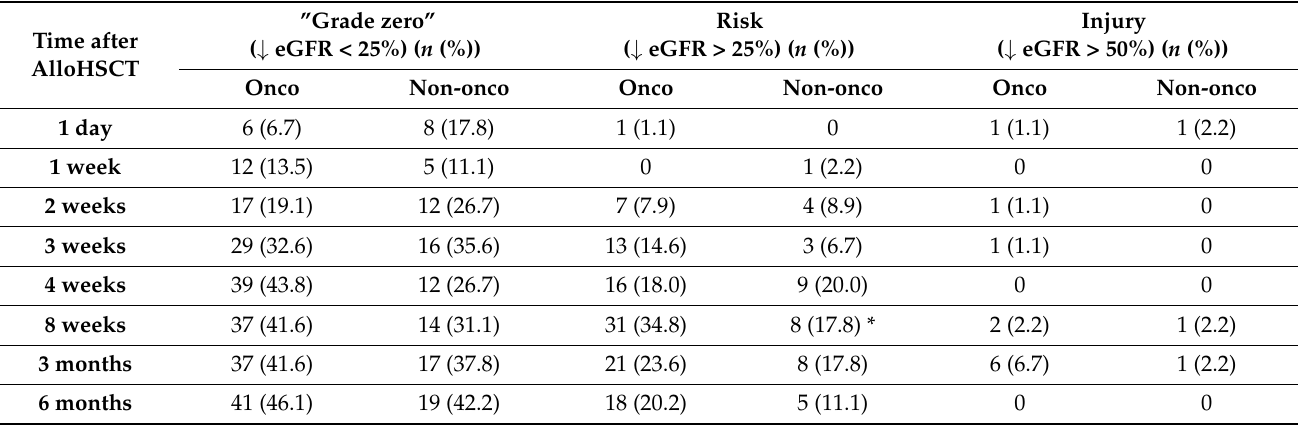
Table 3. The degree of eGFR decrease according to pRIFLE (pediatric Risk, Injury, Failure, Loss and End stage kidney disease) criteria in examined groups in various time